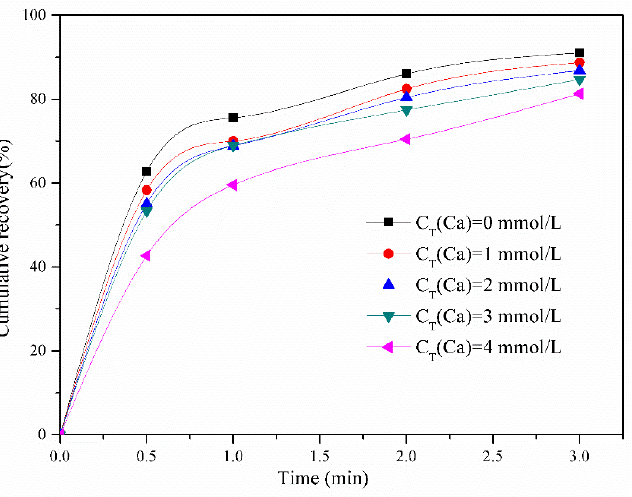
Figure 4. Flotation recovery of molybdenite as a function of time (Kerosene: 350 mg/L; Pine camphor oil: 45 mg/L; pH = 6 ± 0.5).